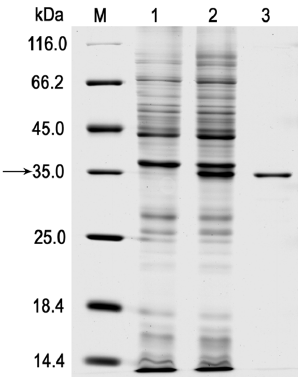
Figure 2. SDS-PAGE of the expression and purification of r-LipA in E. coli . Lane M: molecular weight protein marker; lane 1: total protein extract of induced culture of E. coli /pET-22b (+), as negative control; lane 2: total protein extract of induced culture of E. coli /pET-lipA; lane 3: purified r-LipA after Ni-NTA affinity